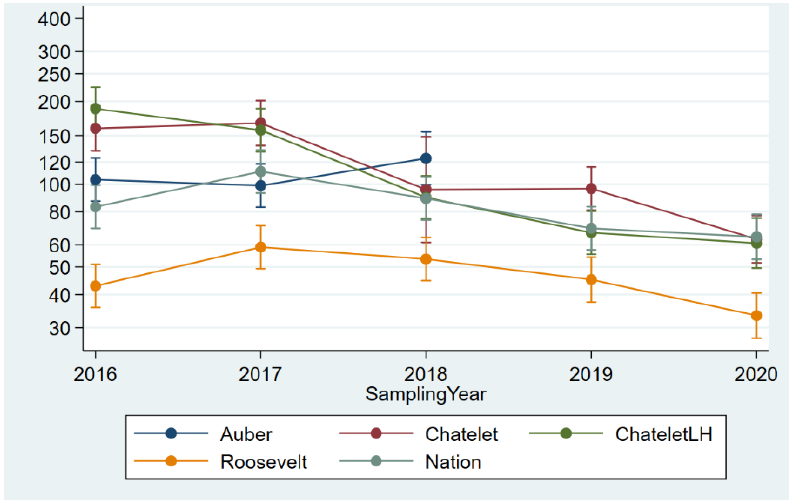
Figure 4. Geometrical means and confidence intervals of the PM 10 mass concentration monitored on five stations of the Parisian subway network over the five last years of the data collection (using TEOM). On the Y -axis: Yearly average (95% CI) of monthly stationary PM 10 measurements (µg/m 3 ) since 2016 according to five underground stations.